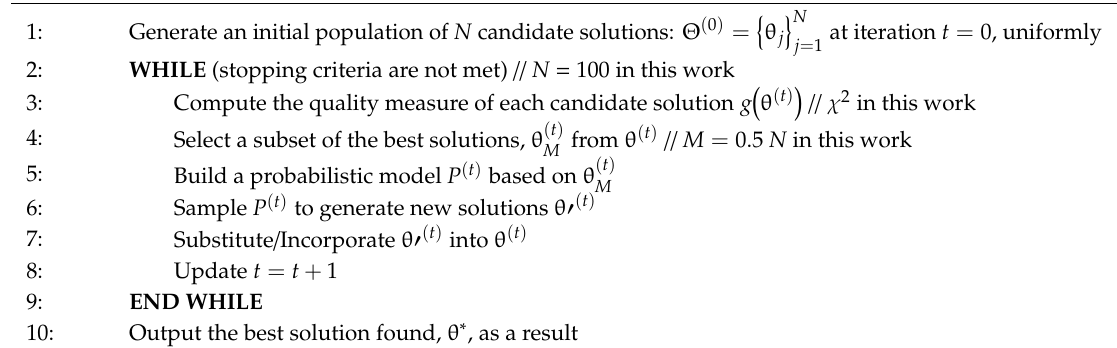
Algorithm 1 General Estimation of Distribution